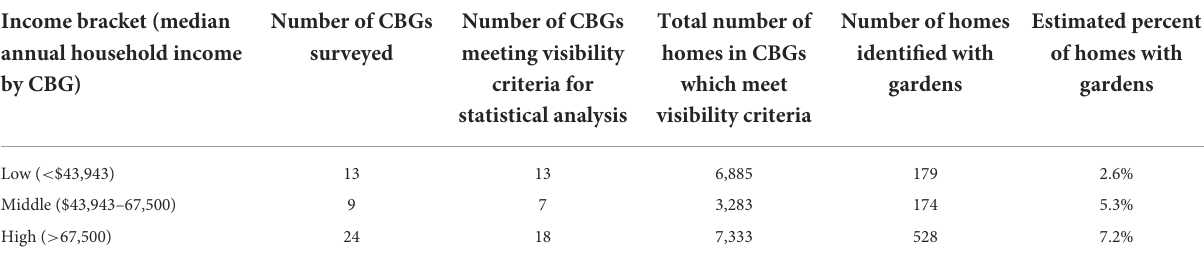
TABLE 1 Census block groups (CBGs), the number of homes surveyed, and those identified with gardens across areas of low-, middle-, and high-income CBGs.